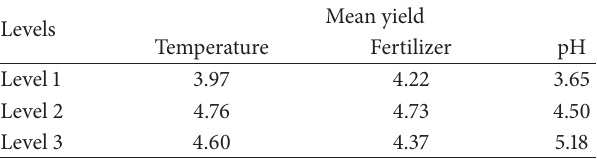
Table 3: The mean yield for each factor at different levels.